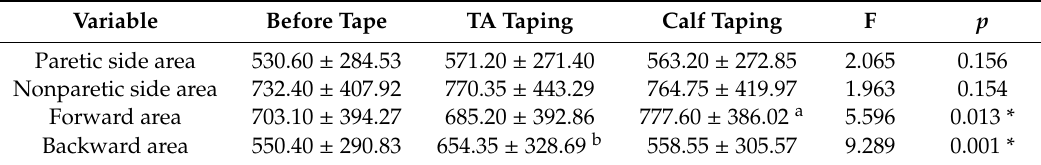
Table 2. Comparisons of center of pressure (COP) excursion for three conditions.